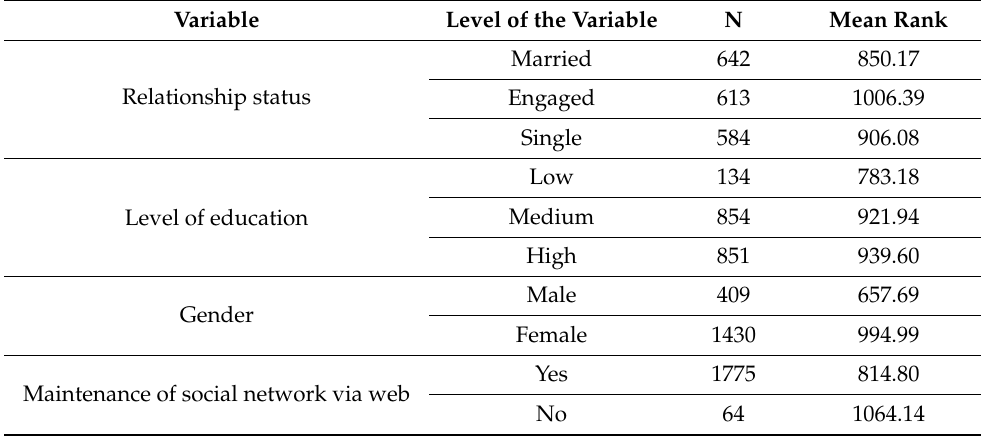
Table 4. IES-R mean ranks according to the independent variables.